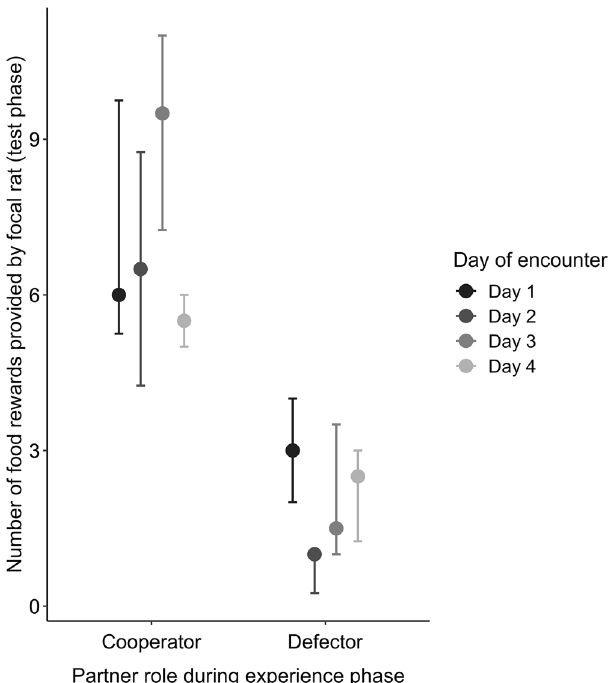
Figure 4. Total number of food rewards provided by focal rats to their cooperating and defecting partners in relation to the point in time when they had experienced their partners. Focal rats provided food rewards more often to previously cooperating than to previously defecting partners, which did not differ between partners experienced a longer or shorter while ago. Medians and interquartile ranges are shown of the focal rats’ pulling frequencies for their partners that had been experienced either on days one, two, three or four (each N =